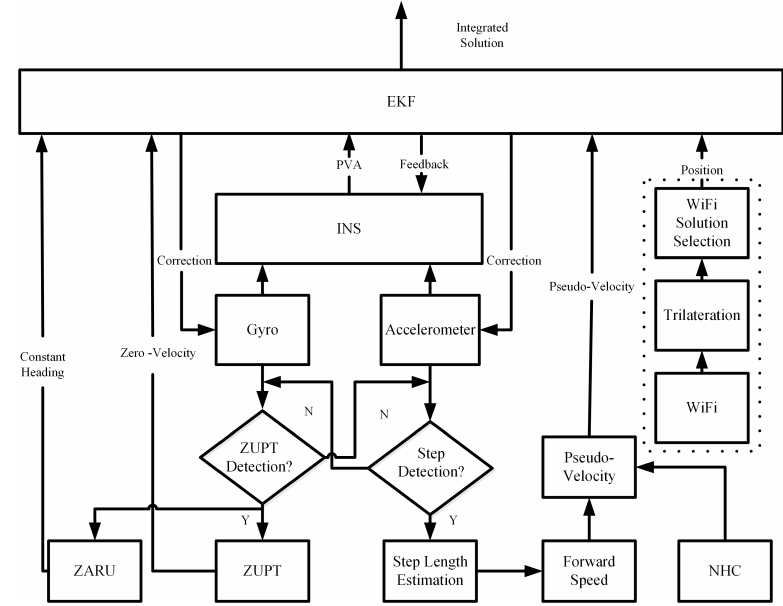
Figure 2. Block diagram of the proposed PDR/INS/WiFi integration